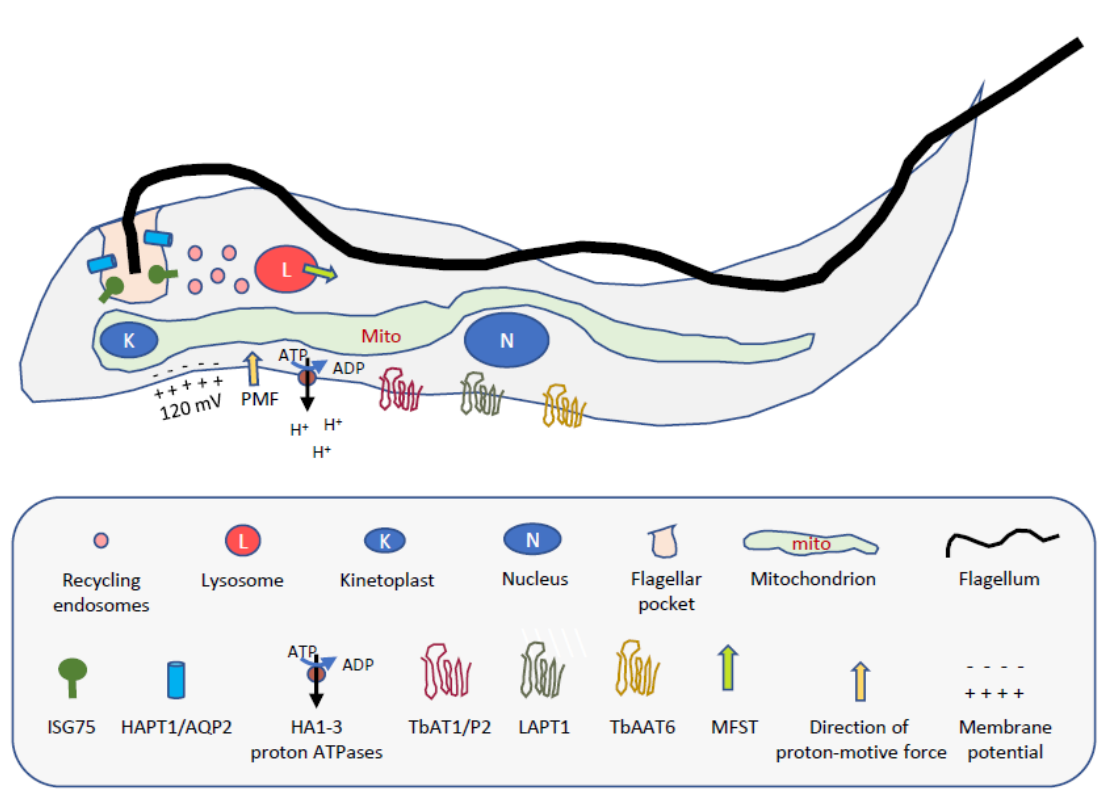
Figure 2. Schematic representation of a T. brucei trypomastigote, indicating some of the structures and proteins involved in the uptake or mechanism of action of trypanocides.